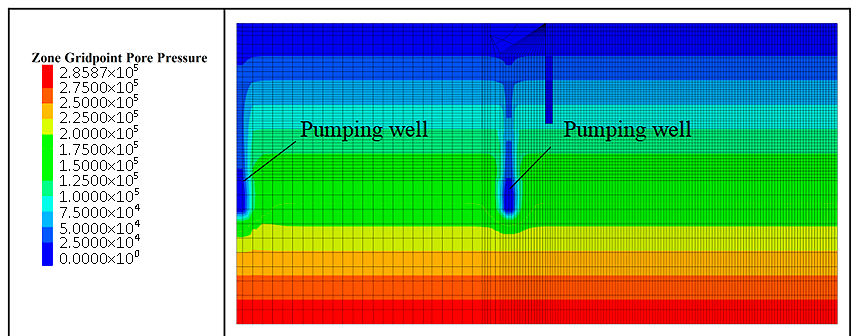
Figure 18. Initial pore water pressure distribution.